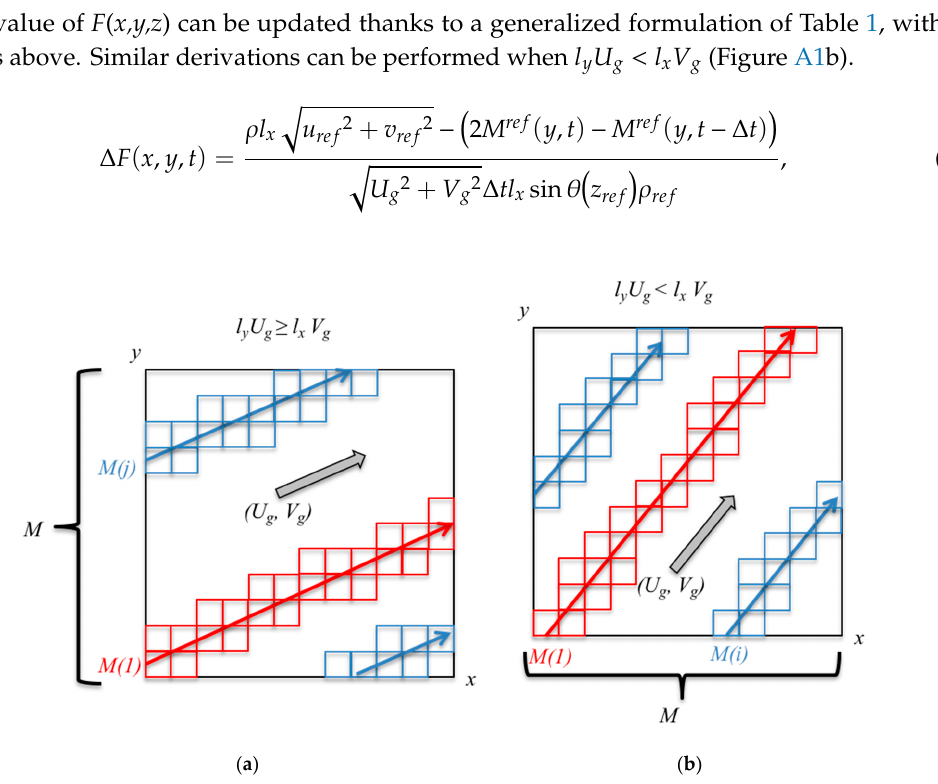
Figure A1. Schematic view of the two configurations for PGF4 implementation, when the wind is not aligned with a domain axis: ( a ) Definition for M along the y -axis; ( b ) definition for M along the x -axis.